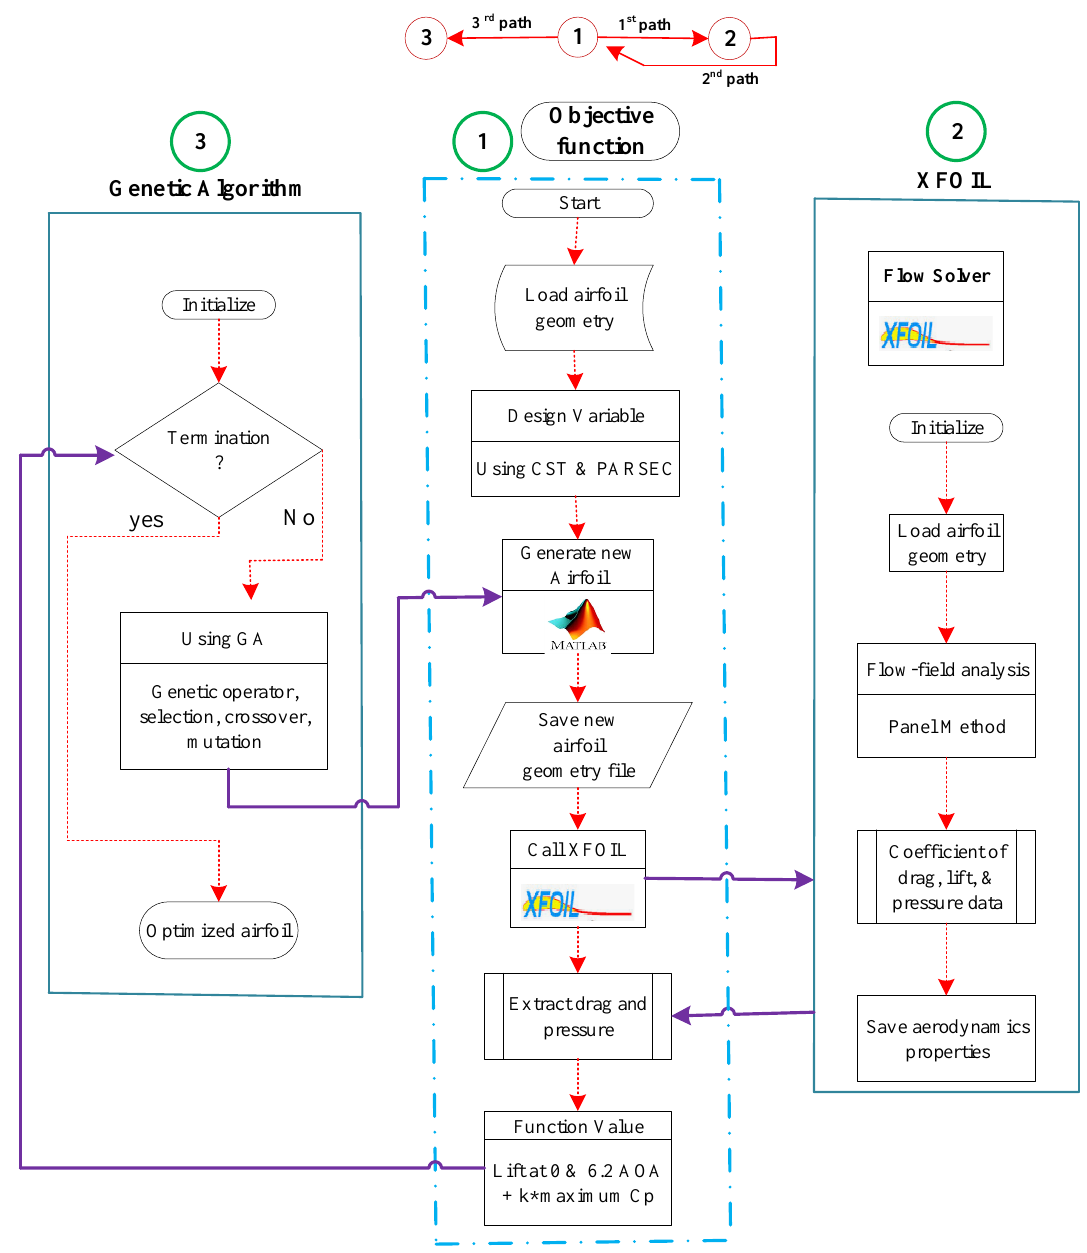
Figure 5. Optimization flow chart elaborating on the MATLAB code for airfoil shape optimization.